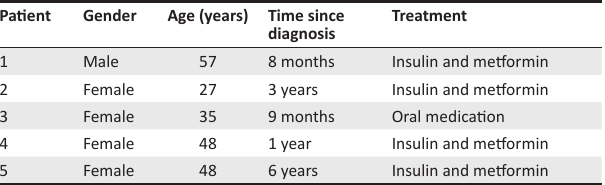
TABLE 1: Characteristics of patients.